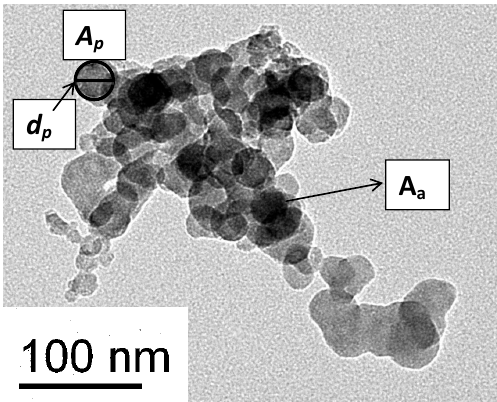
Figure 2. The three measured parameters from the TEM pictures used in this study: the primary particle projected area ( A p ), primary particle diameter ( d p ), and the projected area of the particle ( A a ) .